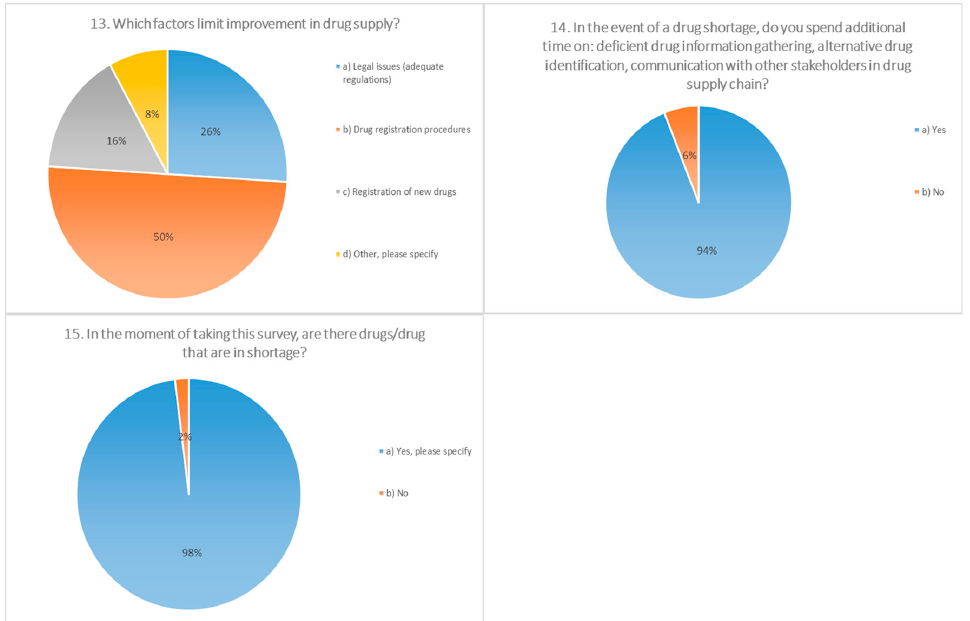
Figure 4. Questions 13 to 15 from a 15-question survey, distributed electronically to community pharmacies in 23 cities in Serbia on behalf of the Faculty of Pharmacy, Novi Sad. The survey was available for completion between February and April, 2019. The survey was anonymous, as contact information was not requested. Data collected from the survey included demographic information. The majority of the questions were multiple choice, allowing respondents to select a pre-specified answer. A total of 500 surveys were administered to community pharmacies .